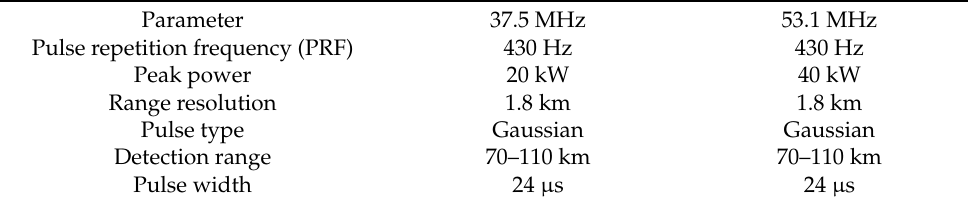
Table 1. Main operating parameters of the two Kunming meteor